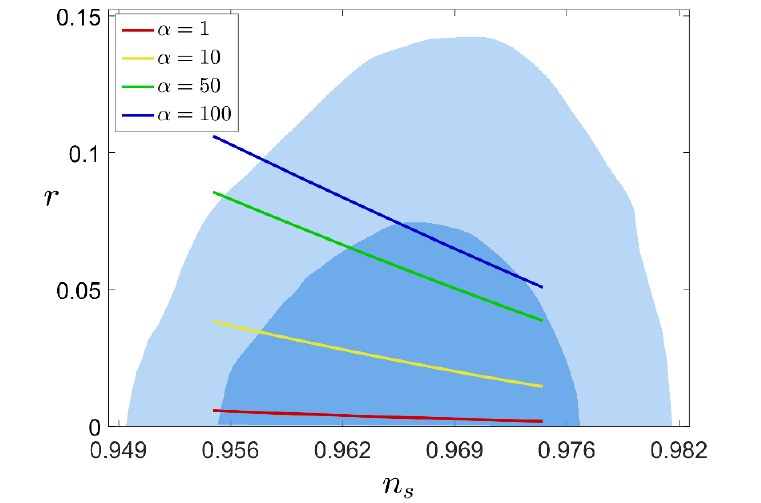
Figure 2. Relationship between r and n s for various values of (cid:11) in the (cid:11) -attractor E-model with n = 1. The sky blue and light blue areas display marginalized joint con(cid:12)dence contours for ( n s ; r ) at the 1 (cid:27) (68%) and 2 (cid:27) (95%) CL [5], respectively. The solid lines correspond to eq. (2.29) for (cid:12)xed (cid:11) and lie within 2 (cid:27) con(cid:12)dence interval of n s ( n s = 0 : 9645 (cid:6) 0 : 0098 [5]). The di(cid:11)erent values of (cid:11) are indicated by di(cid:11)erent